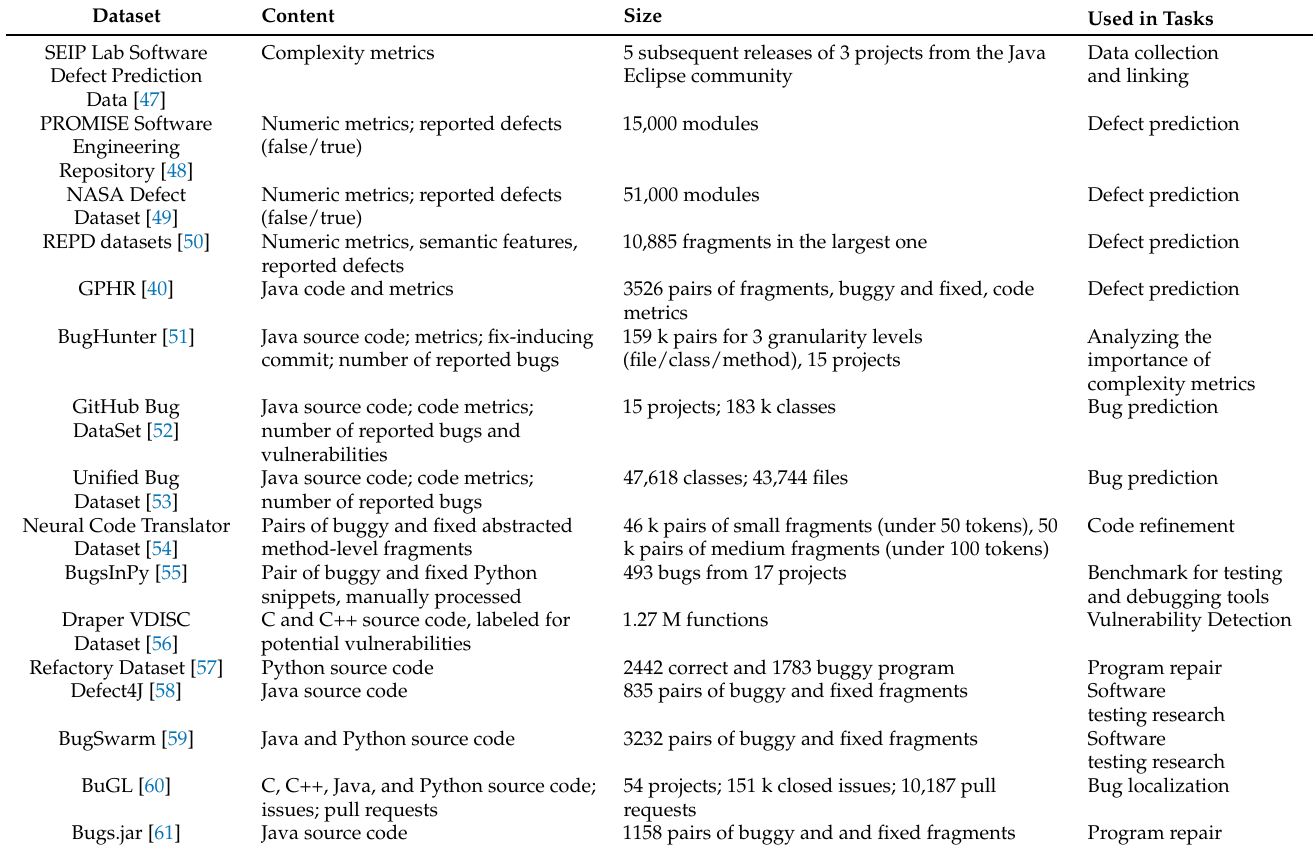
Table 2. List of labeled